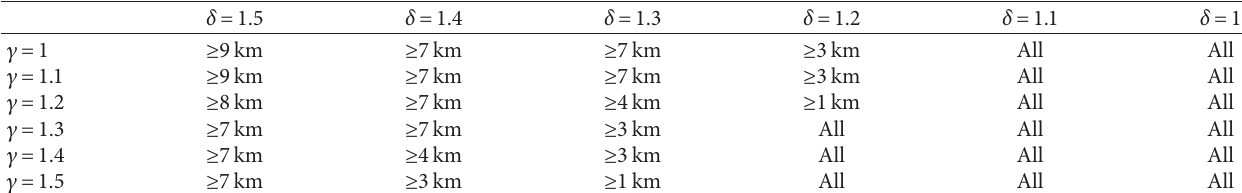
Table 7: The delivery distance of drone superior to rider when t � 5.